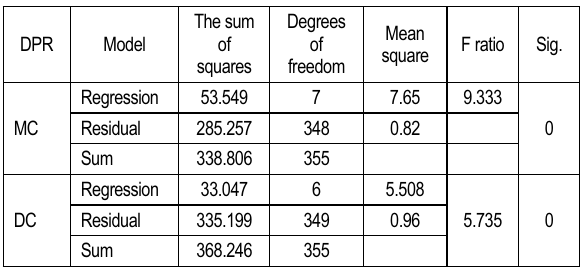
Table 6. Total significance of regression